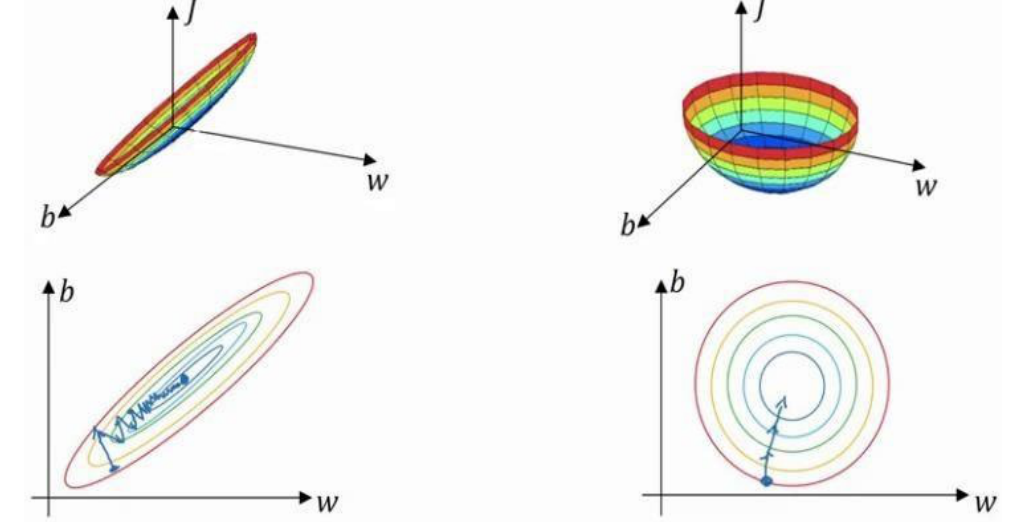
Figure 8. The cost functions for non-optimized ( left ) and optimized features ( right ).